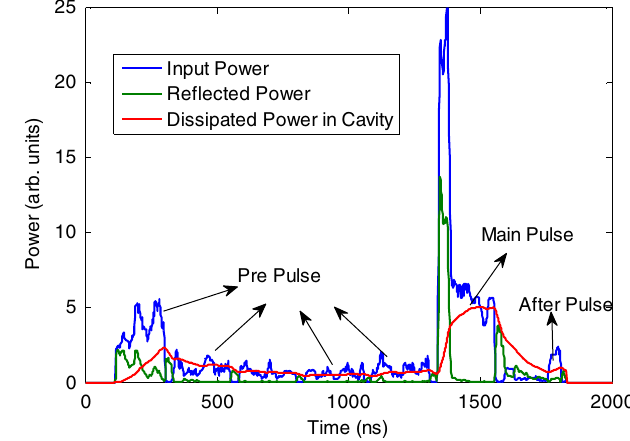
FIG. 3. The X -band SW single cell cavity high-power test setup.